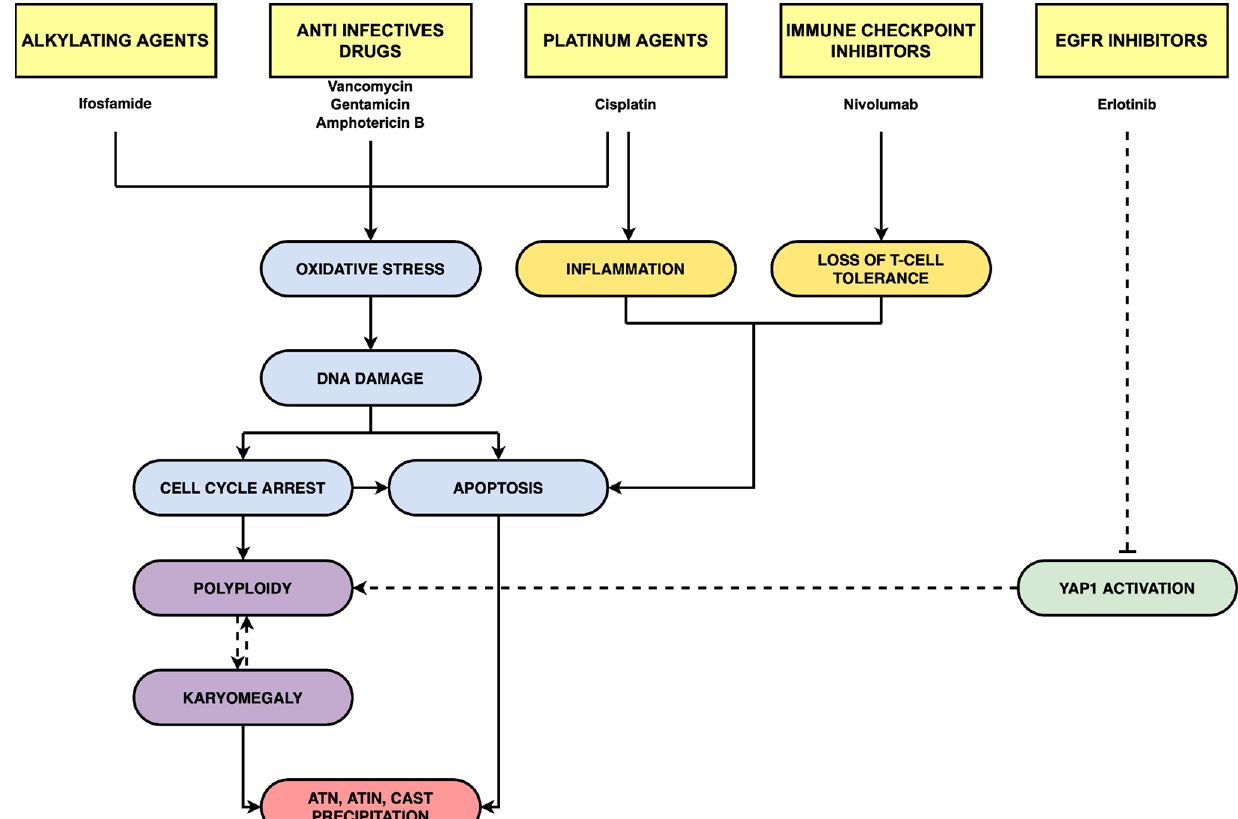
Figure 2. Demonstrated and putative chemotherapy-induced nephrotoxicity mechanisms in tubular epithelial cells. Schematic representation of the various mechanisms through which the drugs reported in this review cause nephrotoxicity. Dotted lines indicate putative mechanisms. ATN: Acute Tubular Necrosis; ATIN: Acute Tubulointerstitial Nephritis . Table 2. Chemotherapy induced-AKI, mechanisms of nephrotoxicity and associated biomarkers.